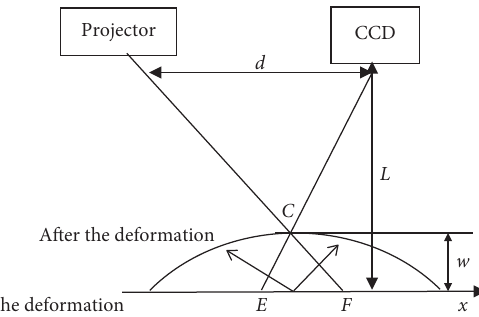
Figure 3: Geometry employed to determine the out-of-plane